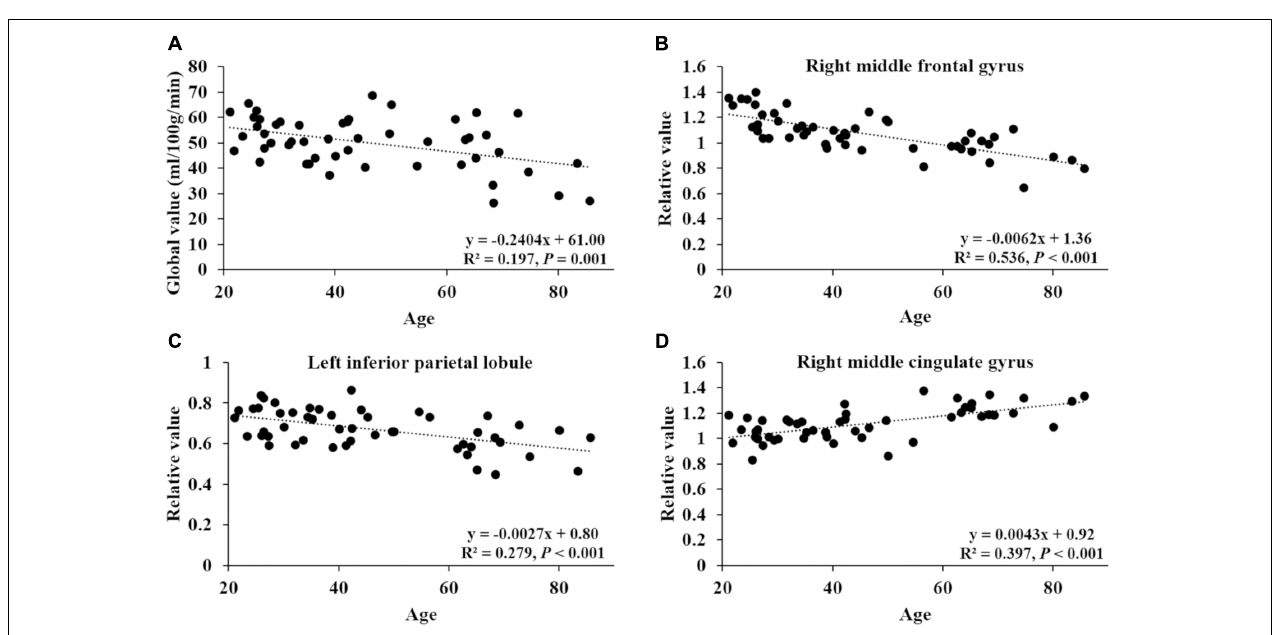
FIGURE 1 | Age-related changes in relative CBF in all participants from regression analysis. Cold color indicates regions in which CBF negatively correlated with age, and warm color indicates regions in which CBF positively correlated with age. A threshold of 2.41 ( P < 0.01) was used to overlay SPM maps onto a standard MRI brain template.